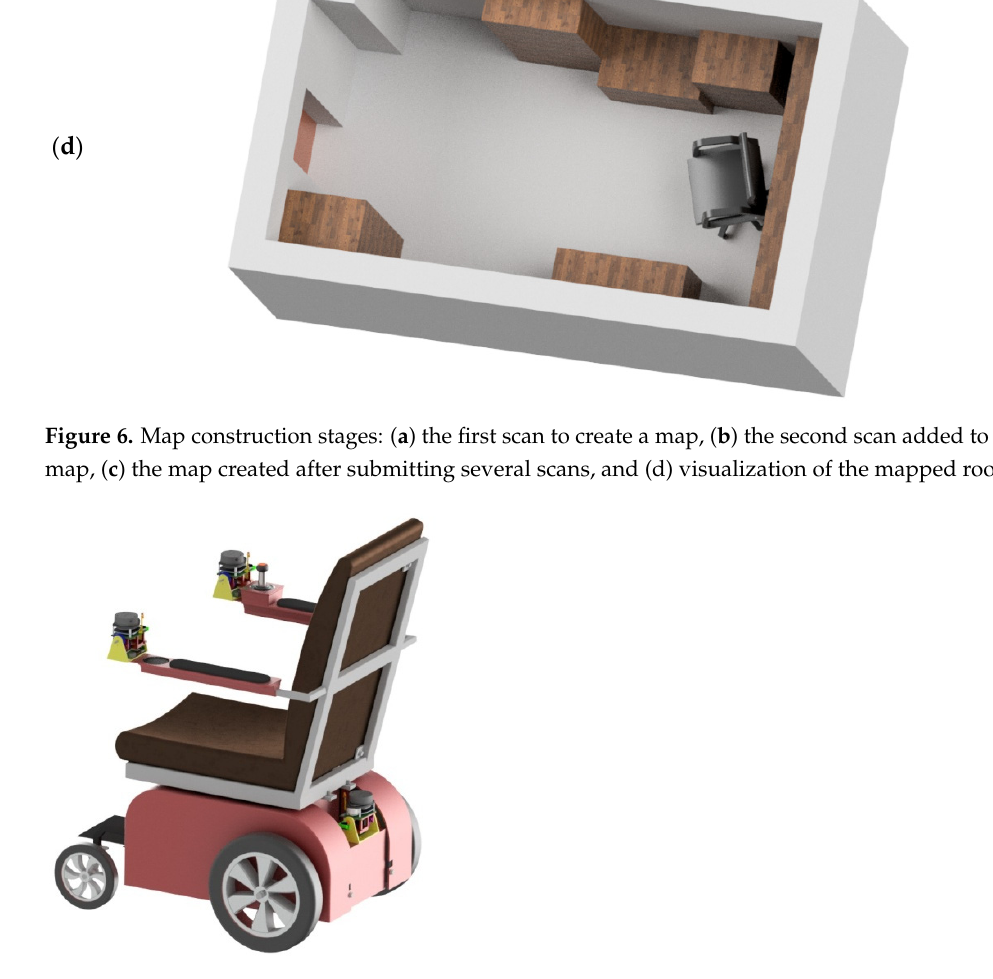
Figure 6. Map construction stages: ( a ) the first scan to create a map, ( b ) the second scan added to the map, ( c ) the map created after submitting several scans, and ( d ) visualization of the mapped room.